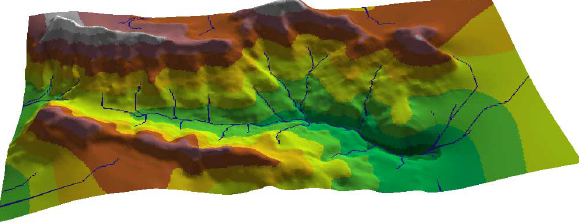
Fig. 8. A 3-D-view of the catchment with the potential rivers flow- paths. This illustration is taken from the official Rietholzbach web- site (http://www.iac.ethz.ch/en/research/riet/ overview.html).